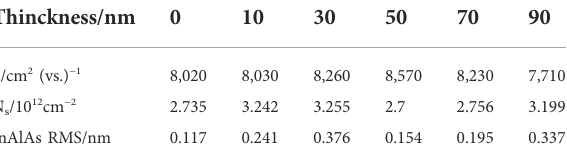
TABLE 2 The performance of the different In x Al 1-x As graded buffer layers with In 0.66 Ga 0.34 As channel. Thinckness/nm